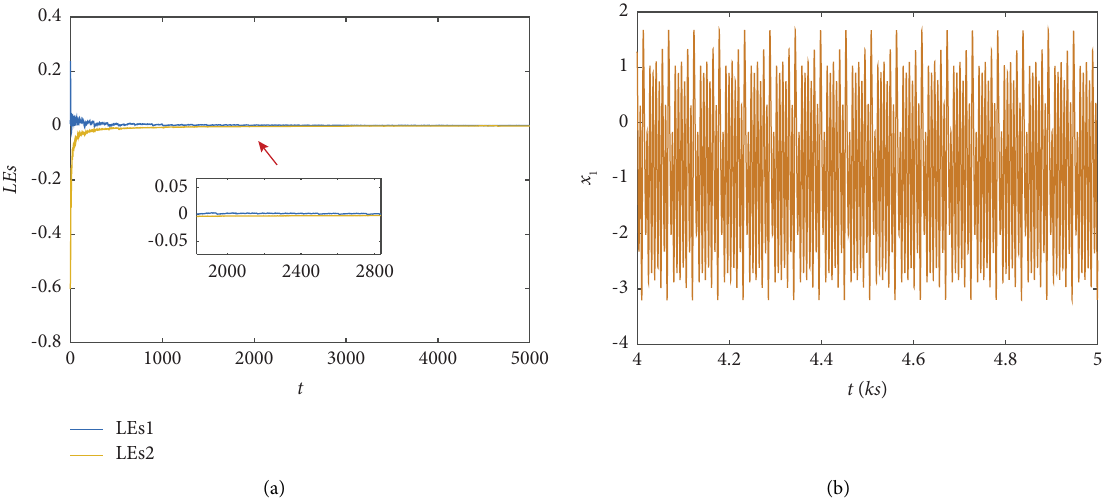
Figure 15: (a) Te time domain waveform of LEs; (b) the time domain waveform of state variable x